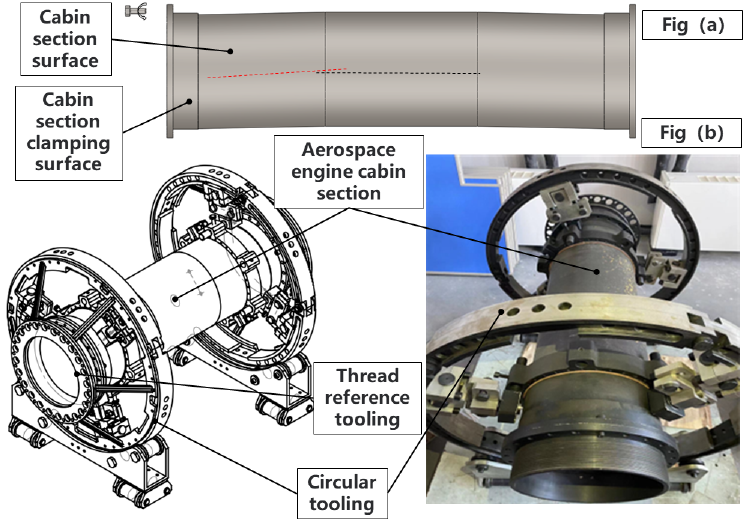
Figure 5. Datum line conversion.